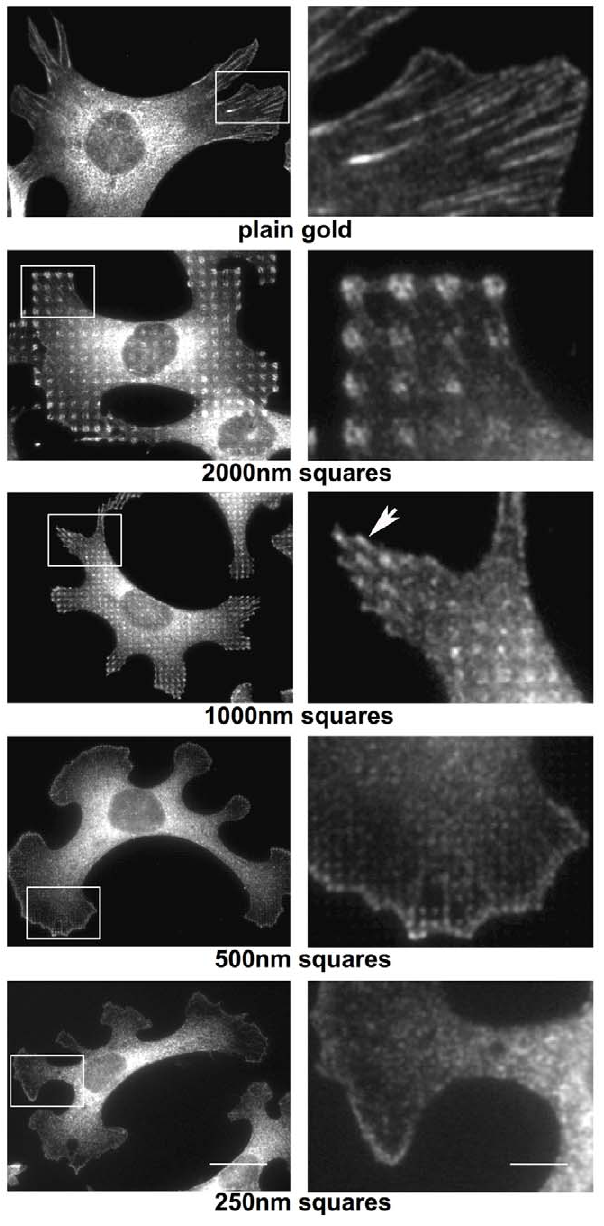
Figure 2. Fibroblasts form matrix adhesions only on RGD- coupled gold areas. Cells were grown on RGD-coupled gold patterns for 4 hours with 3% fibronectin-free serum and subsequently fixed and stained with an anti-vinculin antibody. The images in the right row are enlargements of the boxed areas at left. Note that vinculin staining in cell-matrix adhesions is restricted to RGD-gold nano- and microsquares, whereas on plain RGD-gold vinculin-positive adhesions are several micrometers long. On the 1000 nm pattern, peripheral adhesions over gold squares are elongated in the centripetal direction (arrow). Scale bar is 20 m m (left row) and 5 m m (right row), respectively.